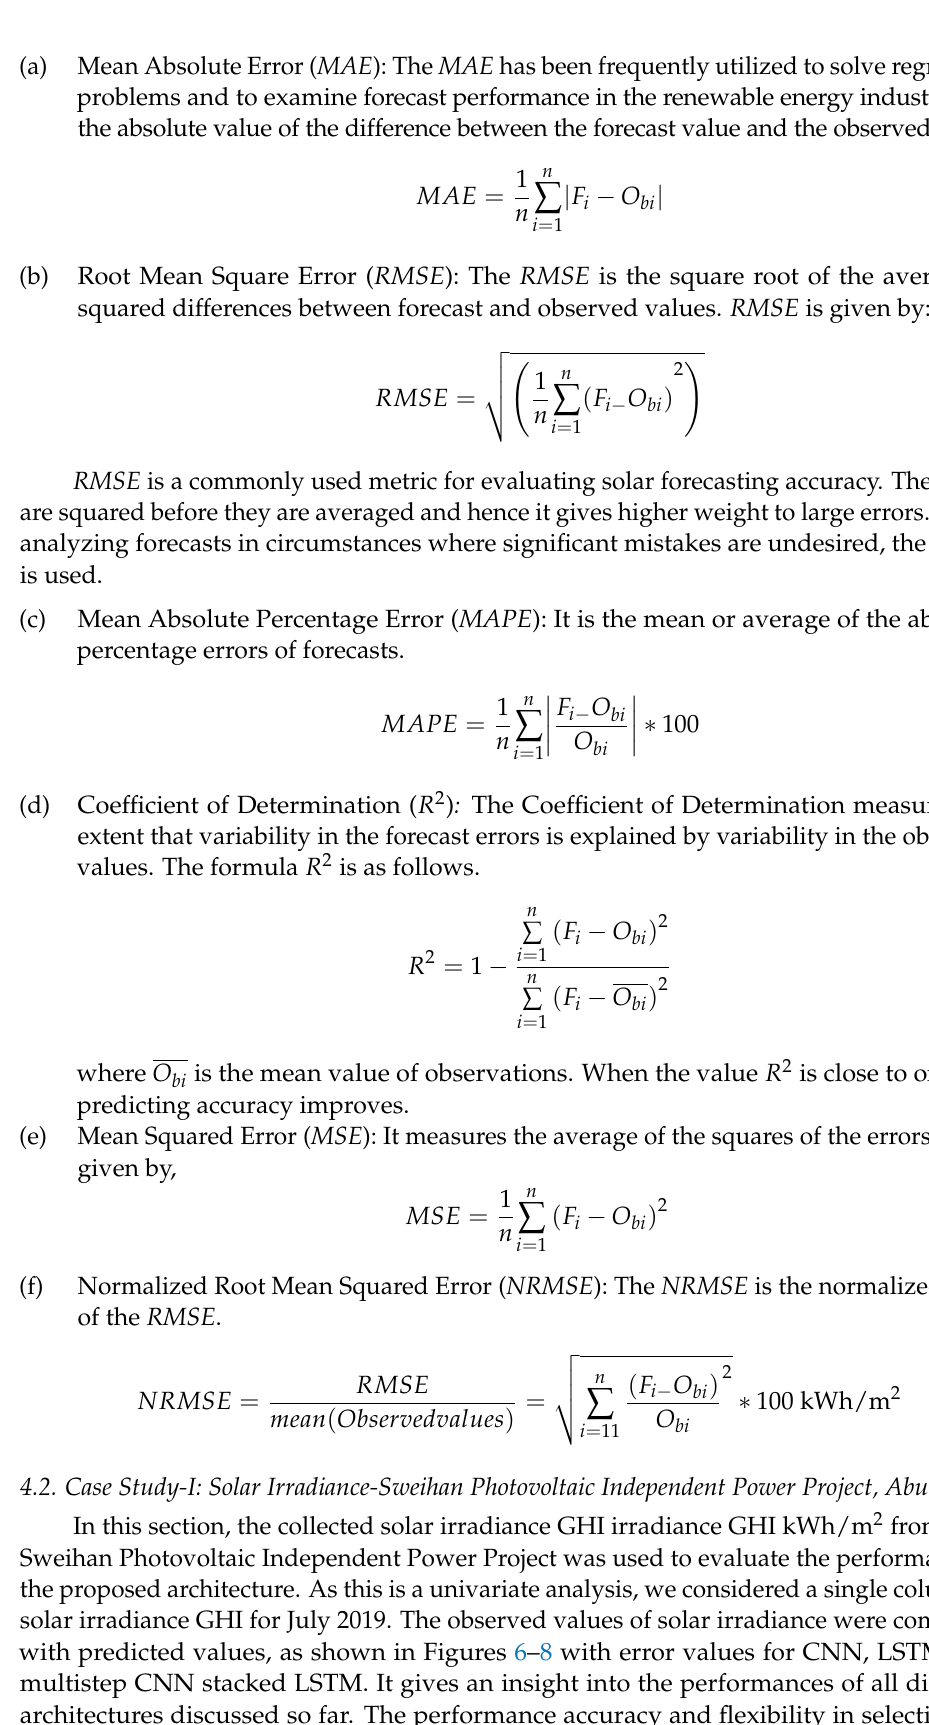
Mean Absolute Error ( MAE ): The MAE has been frequently utilized to solve regression problems and to examine forecast performance in the renewable energy industry. It is the absolute value of the difference between the forecast value and the observed value.